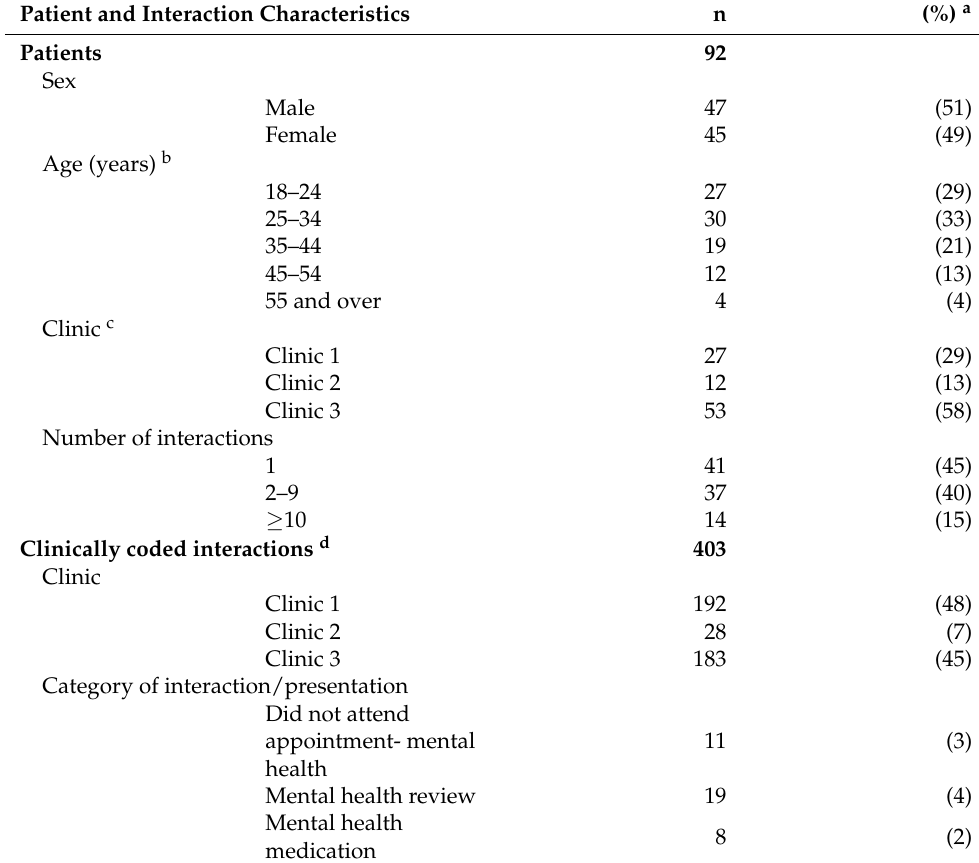
Table 1. Patient and mental health interaction